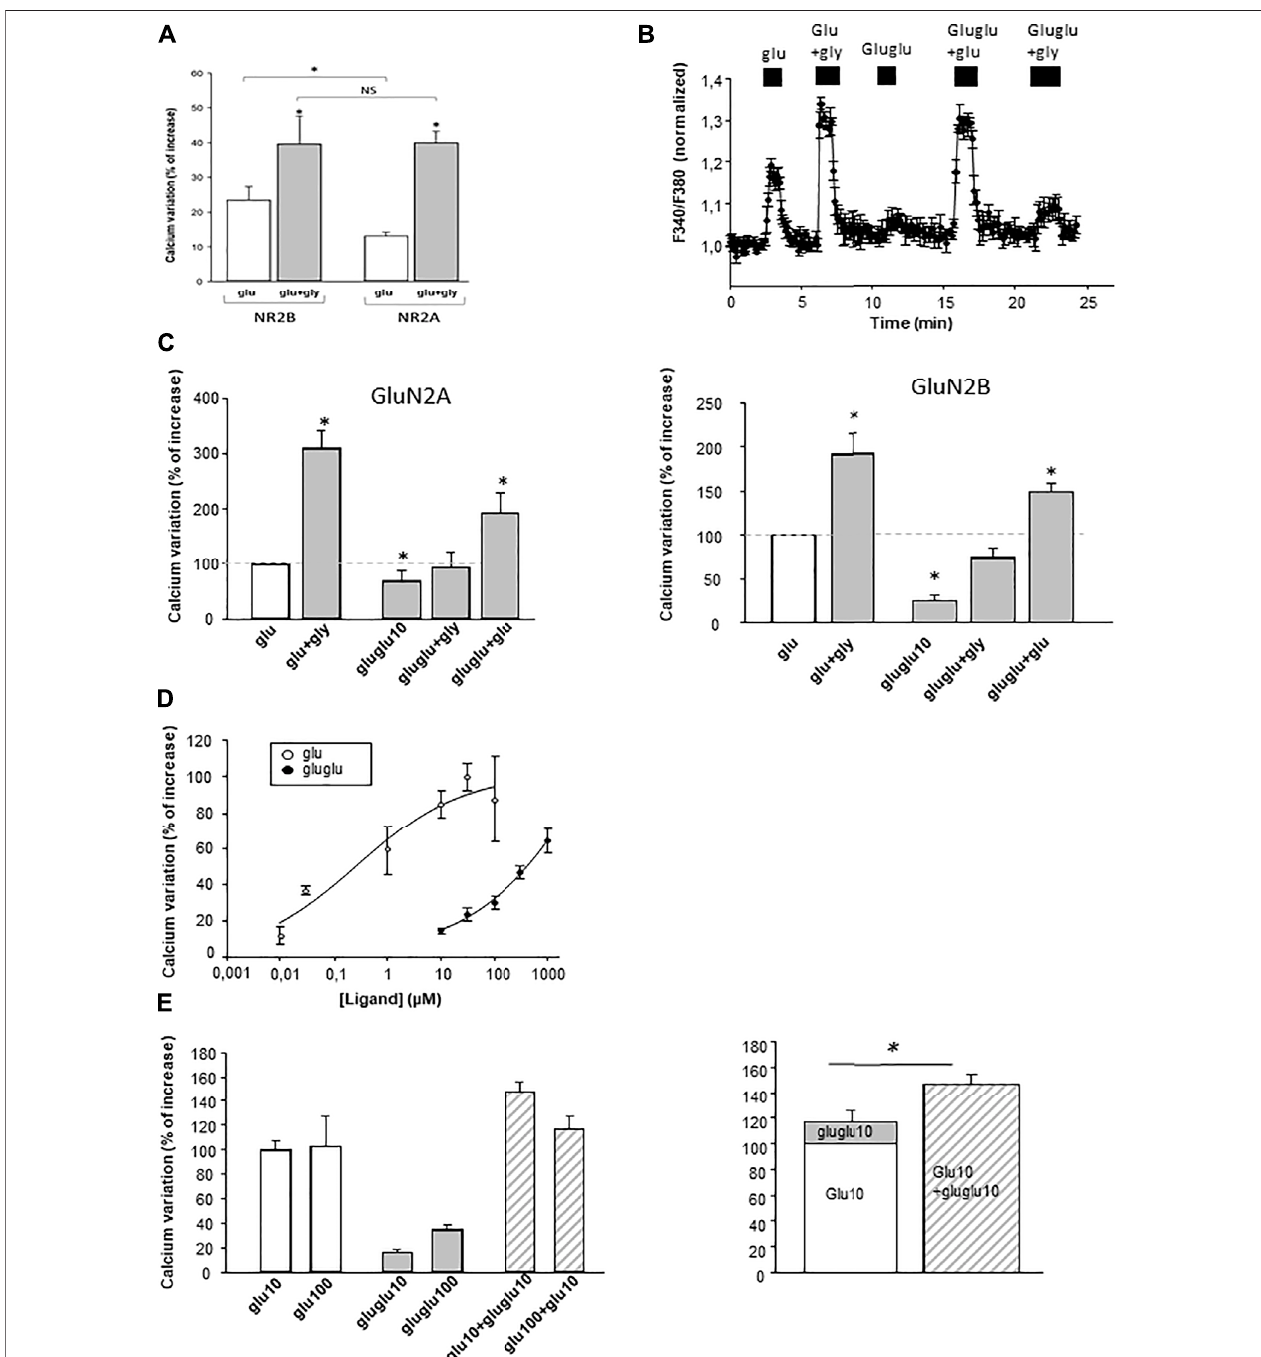
FIGURE 3 | Effect of γ -Glu-Glu on [Ca 2+ ]i on C6 cells transfected with the NMDAr. (A) Comparative effect of 10 µM glutamate and 10 µM glutamate + glycine applicationintheNMDArcomprisingtheGluN2AorGlu2Bsubunit( n (cid:1) 100). (B) Illustrativeexperimentdepictingtheeffectof γ -Glu-GluandGlu,bothappliedat10 µMin thepresenceornotofglycine(gly,10 µM)ontheGluN2B-expressingC6cells( n (cid:1) 3). (C) Recapitulativegraphsplottingtheeffectsof γ -Glu-GluinthepresenceofGluor GlyonGluN2A-(left; n (cid:1) 10)andGluN2B-expressingcells(right; n (cid:1) 17). (D) Concentration-dependentcurveoftheeffectofGluand γ -Glu-Gluon[Ca 2+ ] i measured in GluN2B-expressing cells ( n (cid:1) 15 each). (E) Quantitative analysis of the effect of the combination of Glu (10 µM or 100 µM) with γ -Glu-Glu (10 µM) (left, n (cid:1) 15). On the right,thegraphcomparesthetheoreticalresponseobtainedbyaddingtheindividualresponseselicitedbyGlu(10 µM)andof γ -Glu-Glu(10 µM)(righthistogram)withthe experimental response obtained by co-applying Glu (10 µM) with γ -Glu-Glu (10 µM). * p < 0.05 when comparing both conditions (one-way ANOVA followed by the Holm – Sidak t-test).